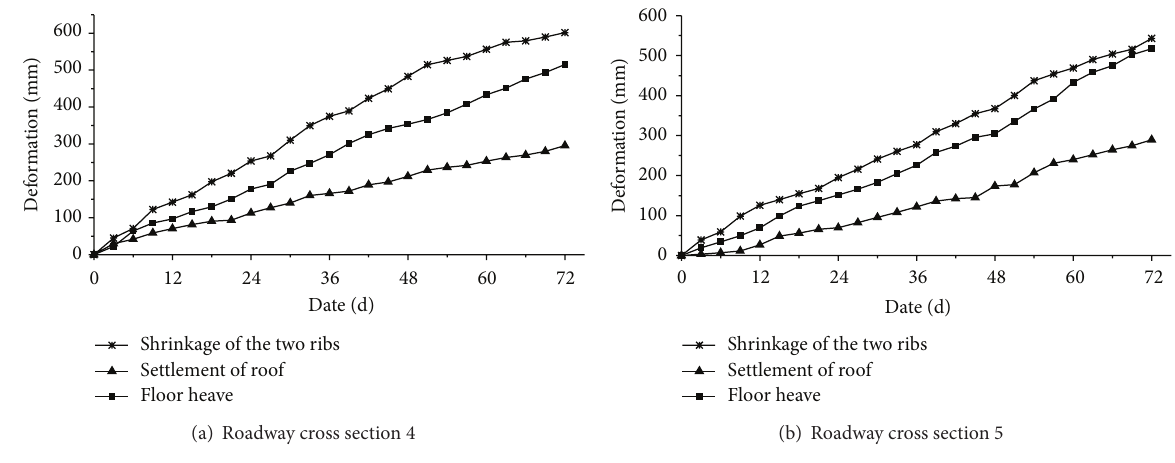
Figure 15: The cumulative deformation of the roadway with the old support